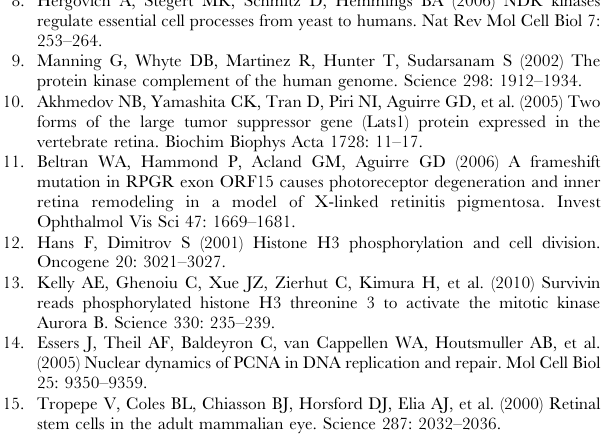
(arrows); (A2, B2) the images of GS labeling shows the lack of label